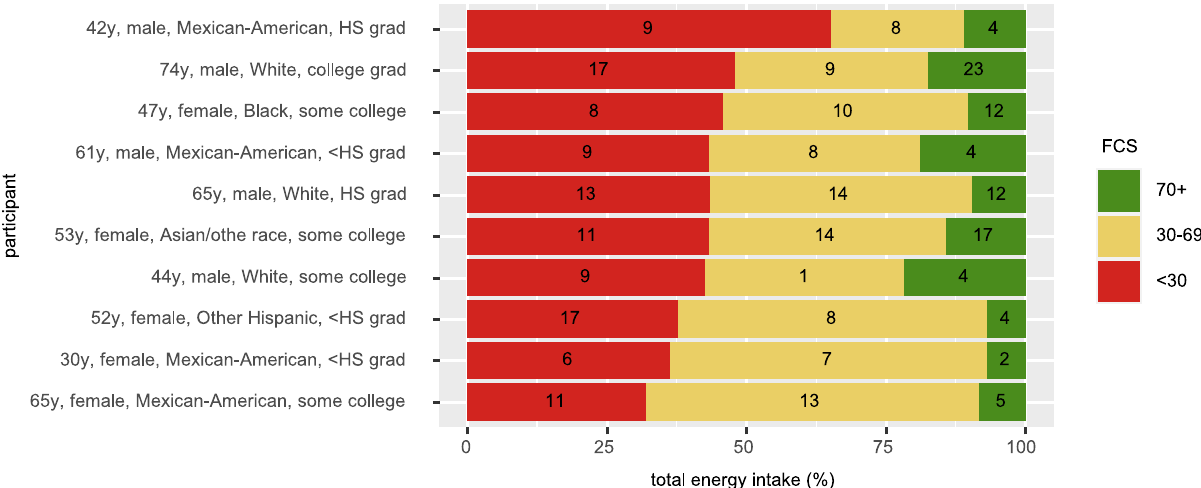
areshownfor10participantswithi.FCSattheU.S.mean(35.5±1)andconsumingat least 10 different products over 2 days of 24 hr recalls. The numbers within each stacked bar graph indicate the count of food and beverage products consumed from that category of FCS across two days of reported intake; and the color bars representthepercentageenergycontributionoffoodandbeverageproductsfrom thatcategoryofFCSacrosstwo daysof reported intake.FCSFood CompassScore, grad graduate, HS high school, i.FCS individual Food Compass